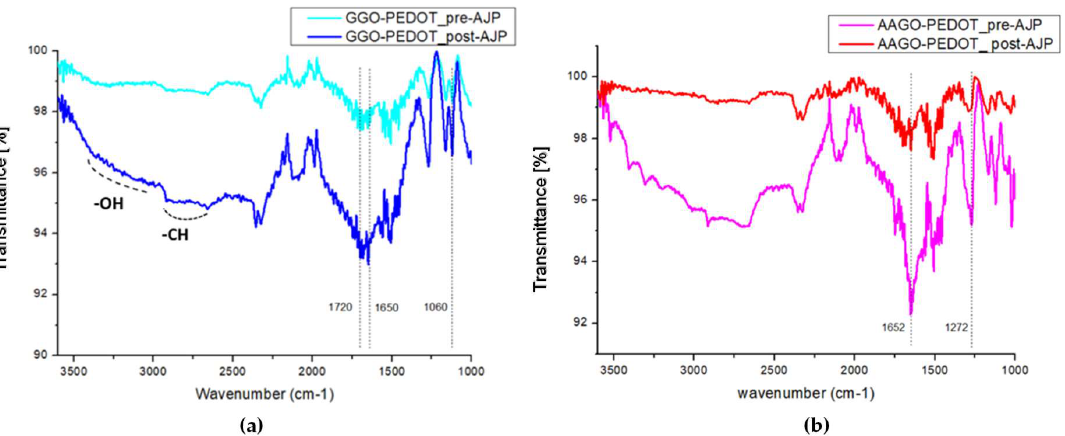
Figure 8. ( a ) Comparison between GGO-PEDOT pre- and post-AJ ® P FT-IR spectrum. ( b ) Comparison between AAGO-PEDOT pre- and post-AJ ® P FT-IR